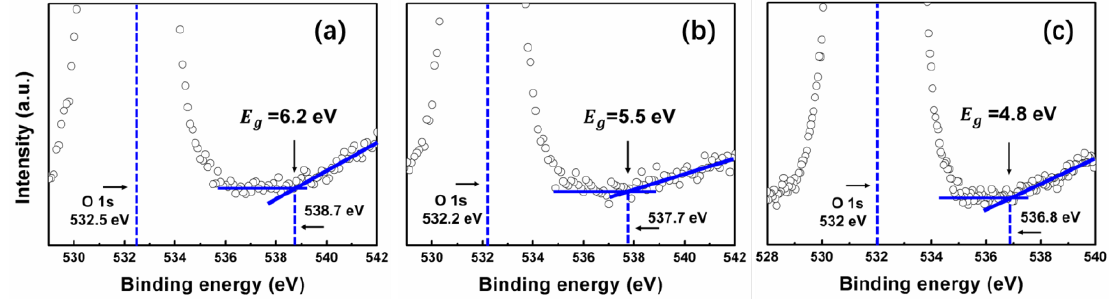
Figure 9. The determination of E g through the O 1s peak analysis by XPS measurement for ( a ) SiON-1, ( b ) SiON-2, and ( c ) SiON-3 film.